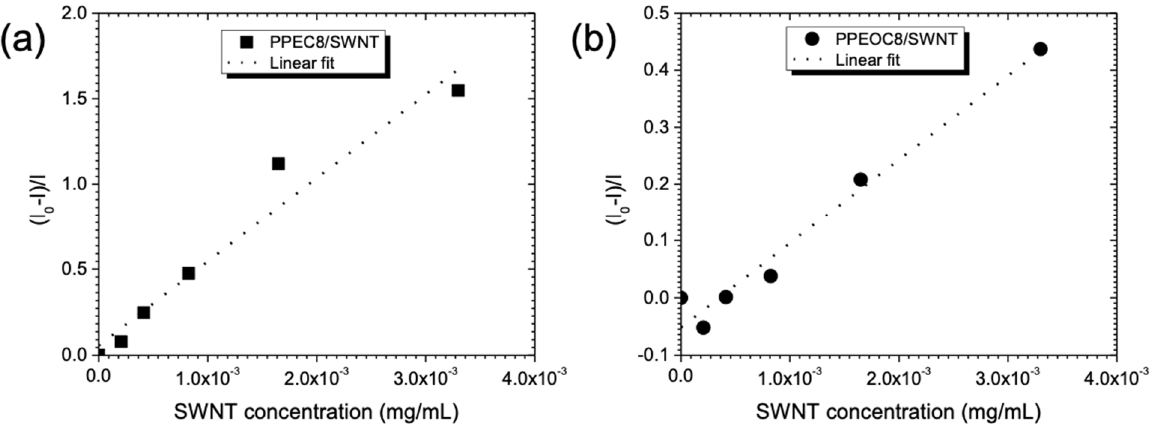
Figure 4. Stern–Volmer plots of change of fluorescence intensity versus SWNT concentration. ( a ) PPEC8-SWNT and ( b ) PPEOC8-SWNT.